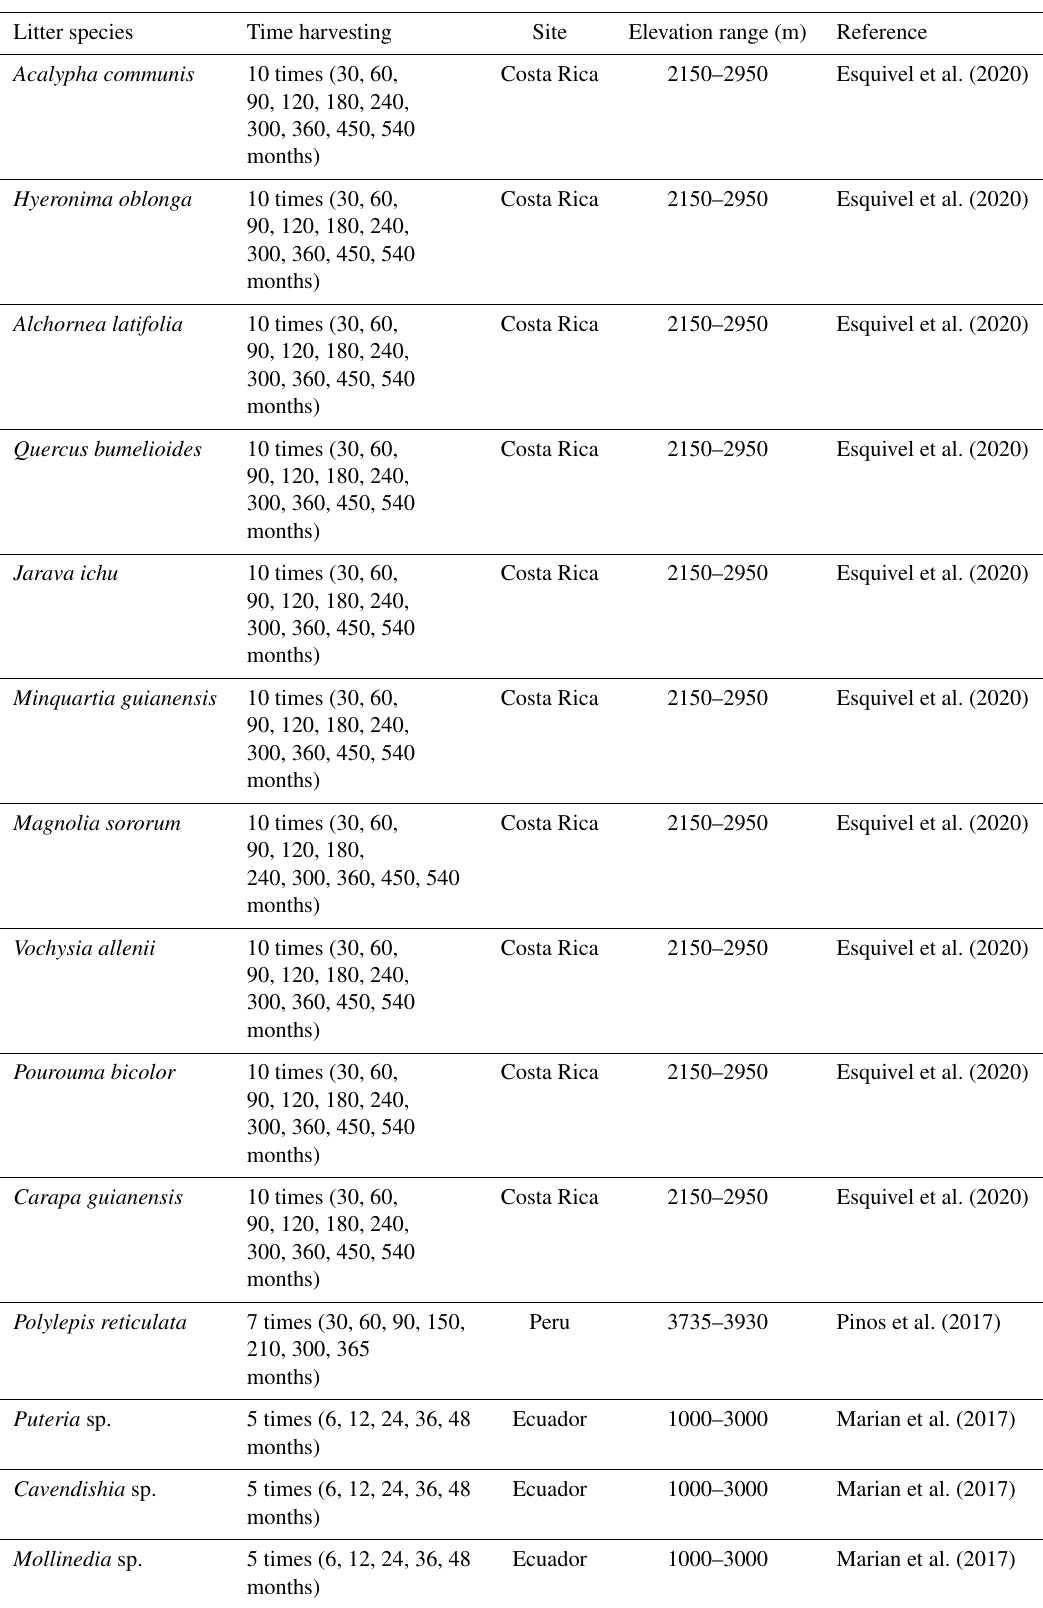
Table B2. Species studied in litter decomposition experiments con- ducted in tropical upland